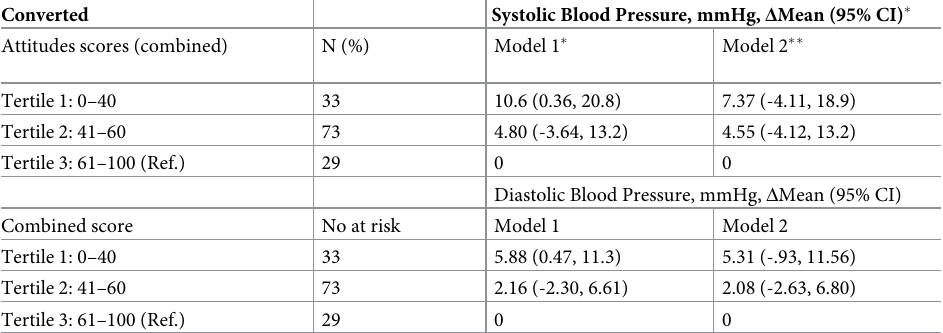
� Estimated effect size, mean with 95% confidence interval (CI) changes compared to people who had 61 to 100% aware and had positive attitudes towards physical exercise. � Model 1: Unadjusted model, and �� Model 2: Age, sex, education and occupation